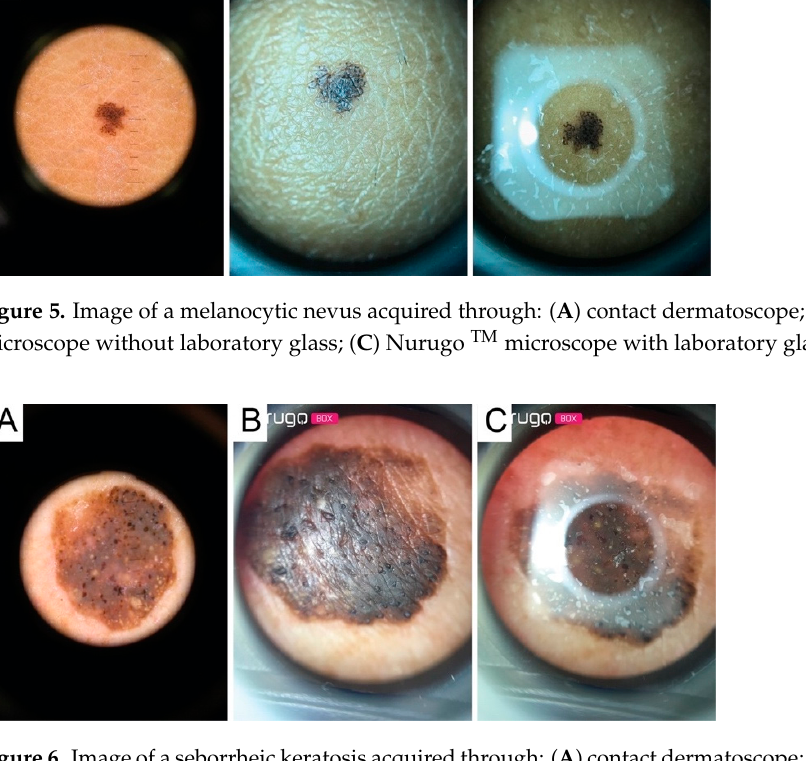
Figure 6. Image of a seborrheic keratosis acquired through: ( A ) contact dermatoscope; ( B ) Nurugo TM microscope without laboratory glass; ( C ) Nurugo TM microscope with laboratory glass.